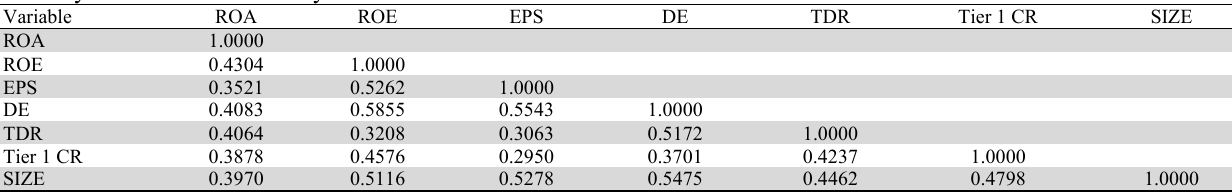
Summary of the correlation